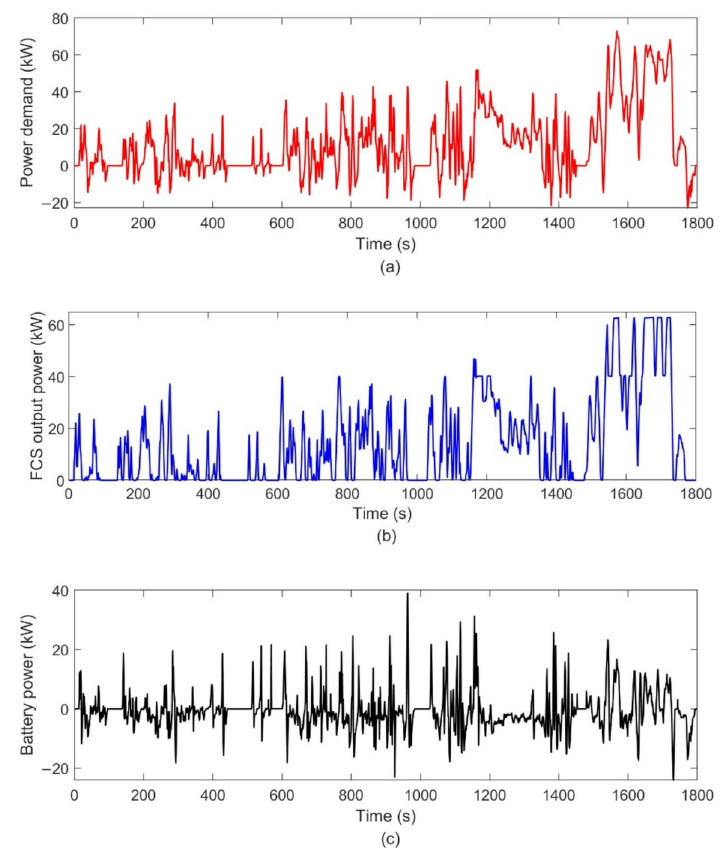
Figure 13. Power allocation with rule-based